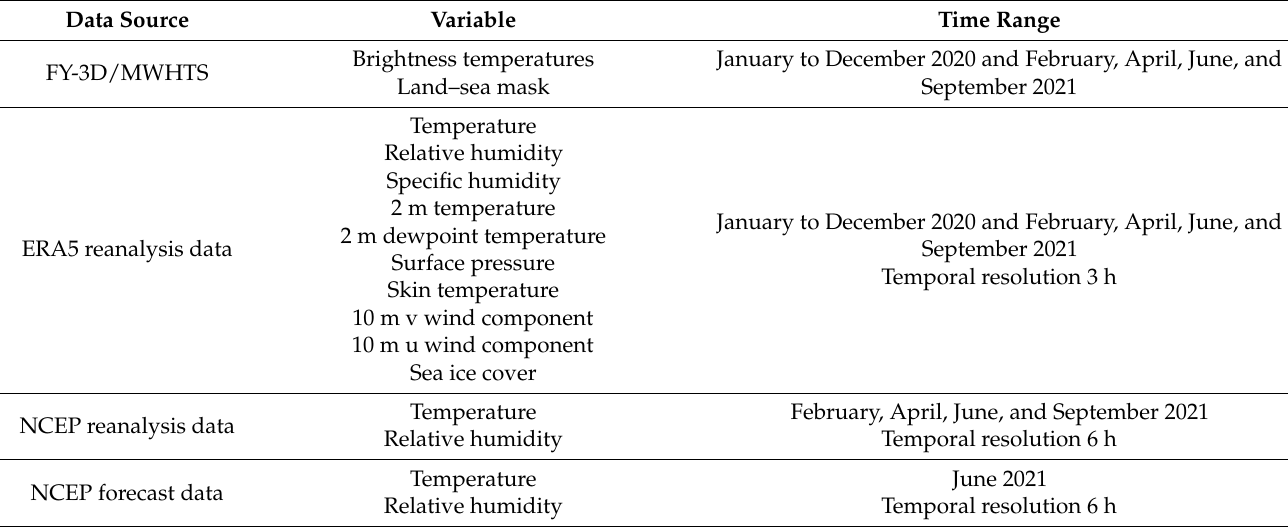
Table 1. Summary of the datasets used for retrieval of atmospheric temperature and humidity